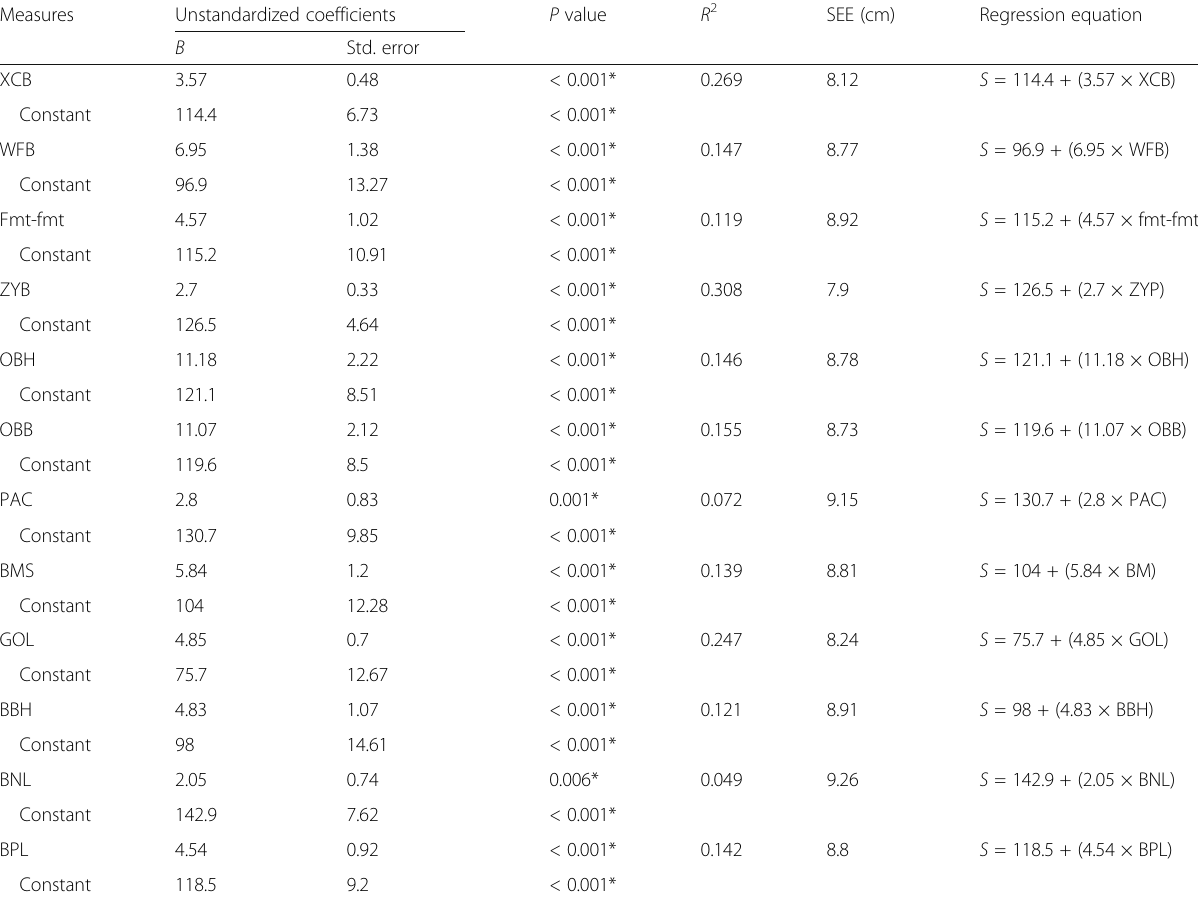
Table 5 Simple linear regression analysis to predict stature from skull measurements in pooled cases ( n = 150)